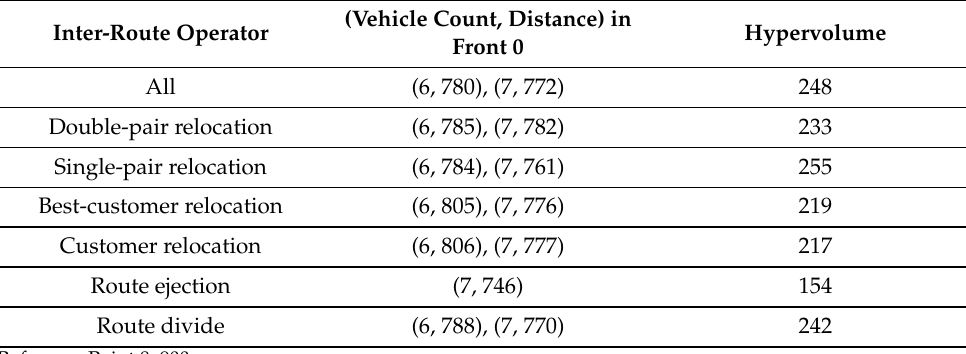
Table 9. Inter-route operation effects on solution quality of bar-n100-5 [29].